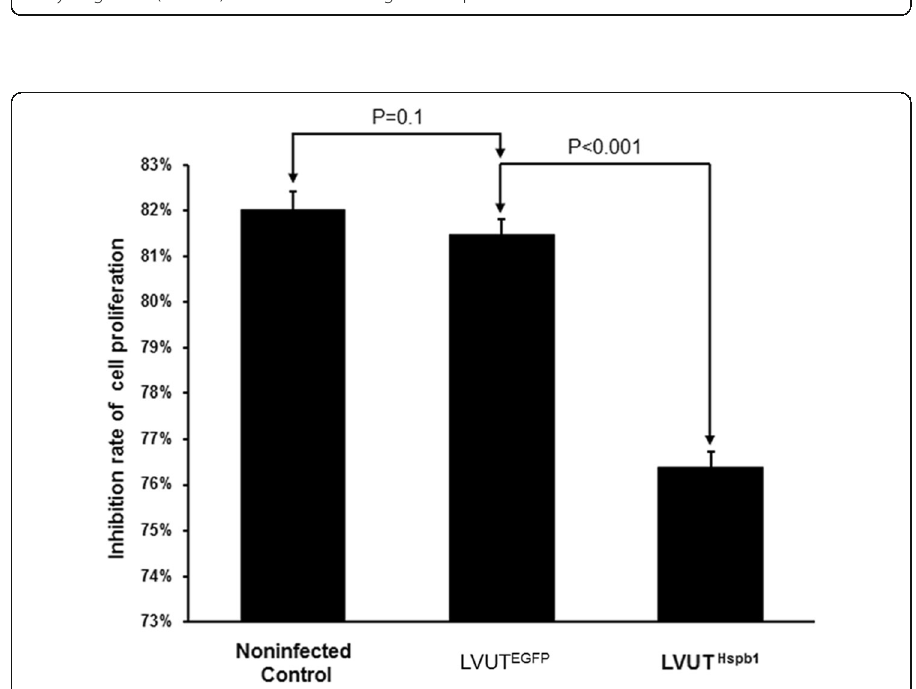
Fig. 5 A10 cells were treated with 2 mmol/l of H 2 O 2 for 2 h. Cell proliferation was assayed with an MTT assay kit. H 2 O 2 inhibited cell proliferation dramatically, but the inhibition rate was lower in A10 cells infected with LVUT Hspb1 than in A10 cells infected with LVUT EGFP ( p <0.001). There were no significant differences between the non-infected control and LVUT EGFP ( n